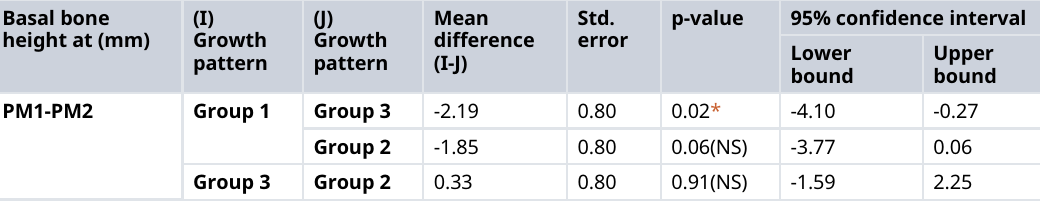
Table 2b. Pairwise comparison of Basal bone height between the study groups. Basal bone height at (mm)